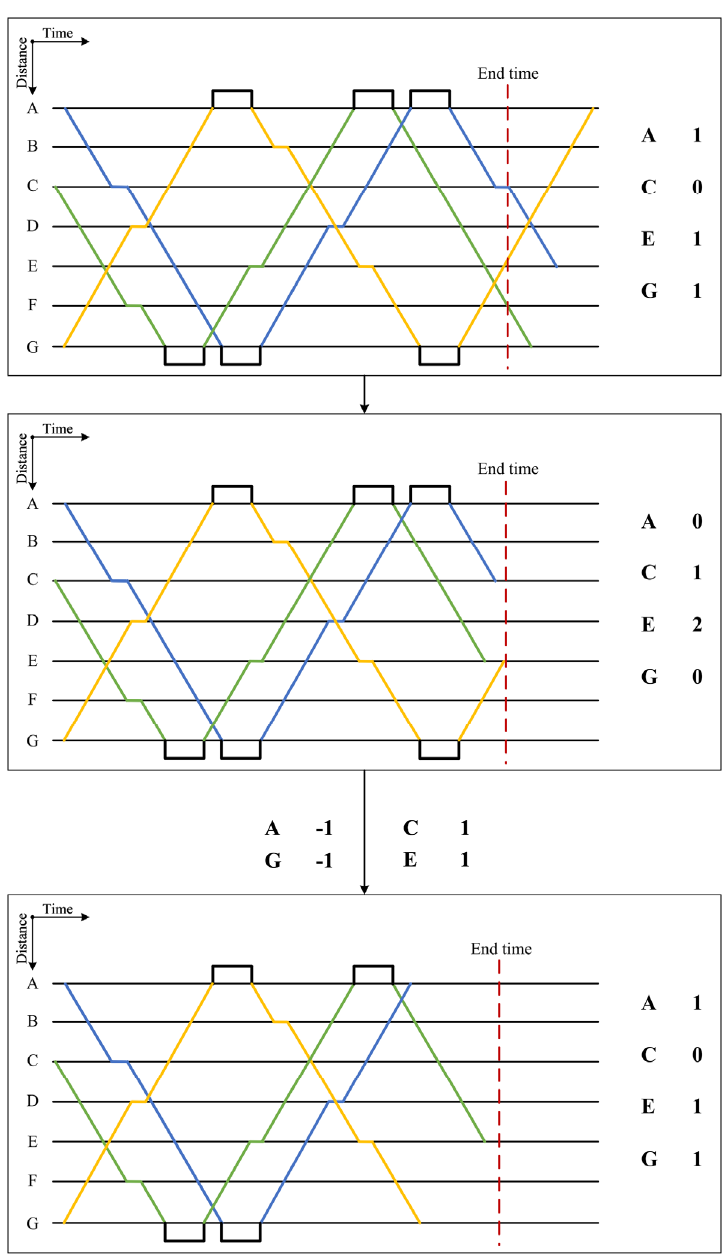
Figure 14. The schematic diagram of adjustment steps.